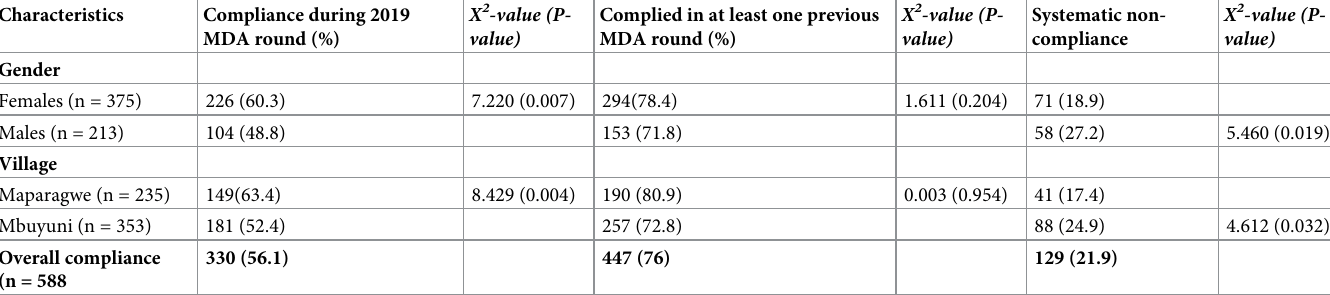
Table 4. Level of compliance to taking Ivermectin and Albendazole during MDA by gender and village of residence.